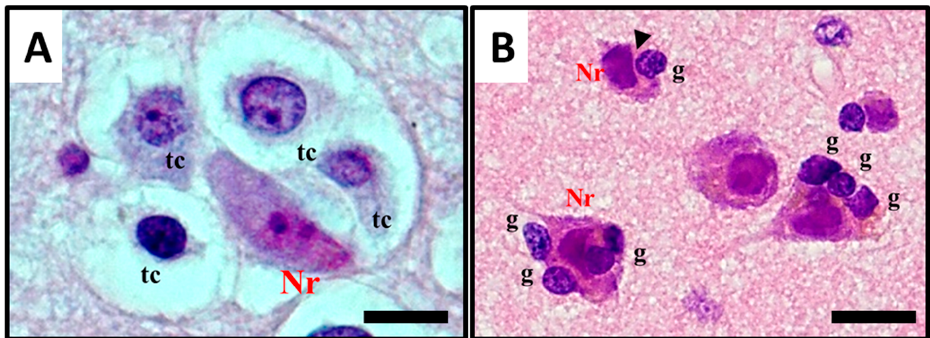
Figure 4. Histological observation and description of ( A ) perineuronal satellitosis in glioblastomas (GB) and ( B ) perineuronal satellitosis in non-neoplastic brain damage condition. ( A ). Polymorphic, markedly atypical glial tumour cells (tc) surrounding a neuron (Nr), which nevertheless shows only mild sign of cellular, mostly hypoxic stress (darkened colour of nucleus and cytoplasm, focal vacuolisation, chromatic dispersion); ( B ) Slightly atypical, non-neoplastic glial cells (g) are surrounding neurons (Nr) with little changes, mostly due to hypoxic stress, in the collateral brain tissue of an active plaque (patient with relapsing multiple sclerosis). The contact between the cell’s shapes, not only cytoplasmic but also nucleus structure, creating nuclear membrane indentations ( (cid:73) ). All images are shown at 400× magnification and relative regions of interest (ROI) are reported. The scale bars are 50 µm.